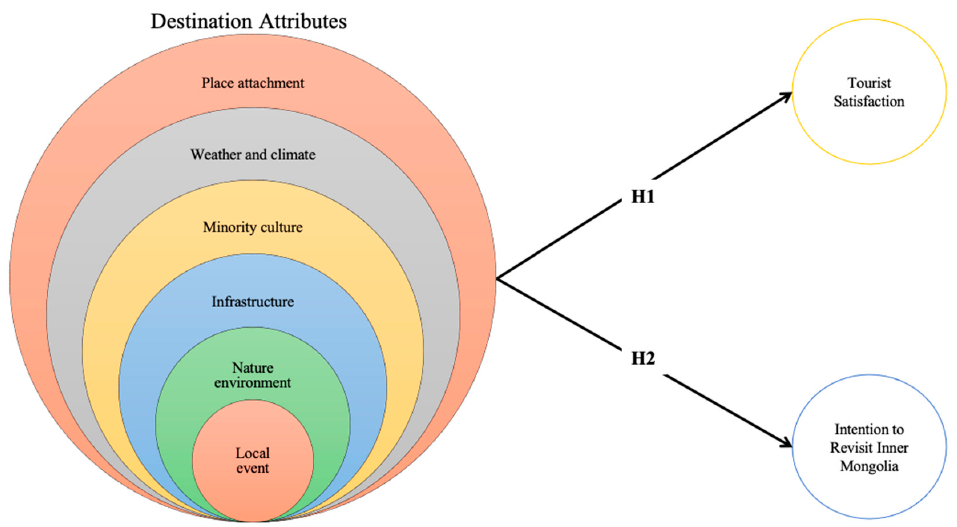
Figure 2. Proposed